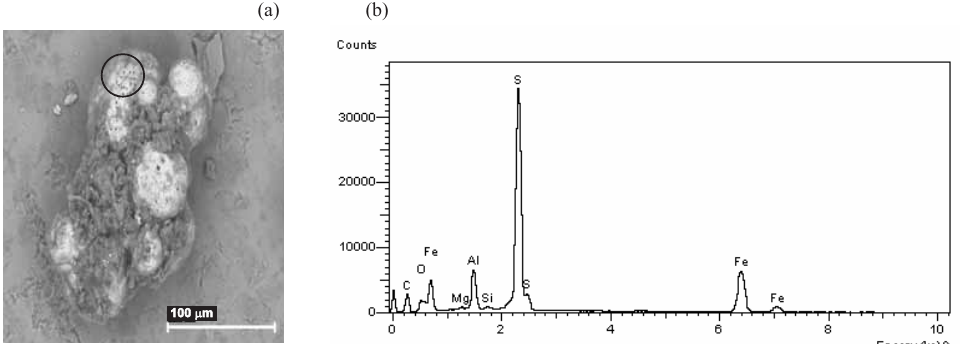
Figura 6. Microscopia eletrônica de varredura (a) e espectroscopia de energia dispersiva (b) de uma pirita do perfil H16 em estado avançado de oxidação, evidenciado pelos espaços vazios (destaque) e ausência de cristais bem